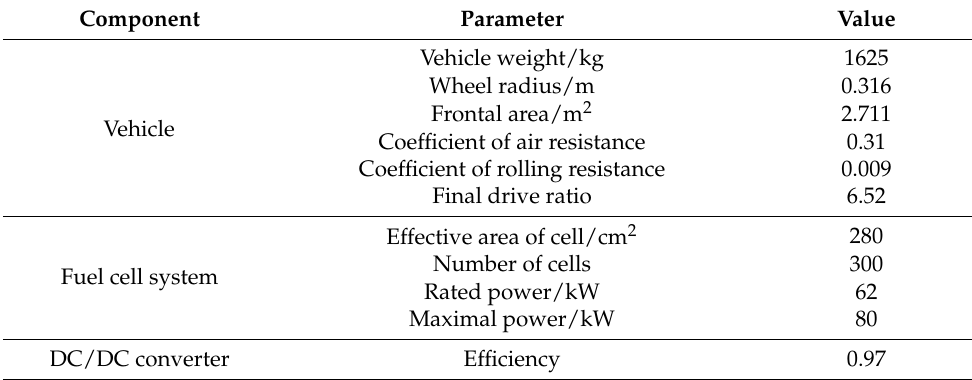
Table 1. Parameters of the fuel cell hybrid electric